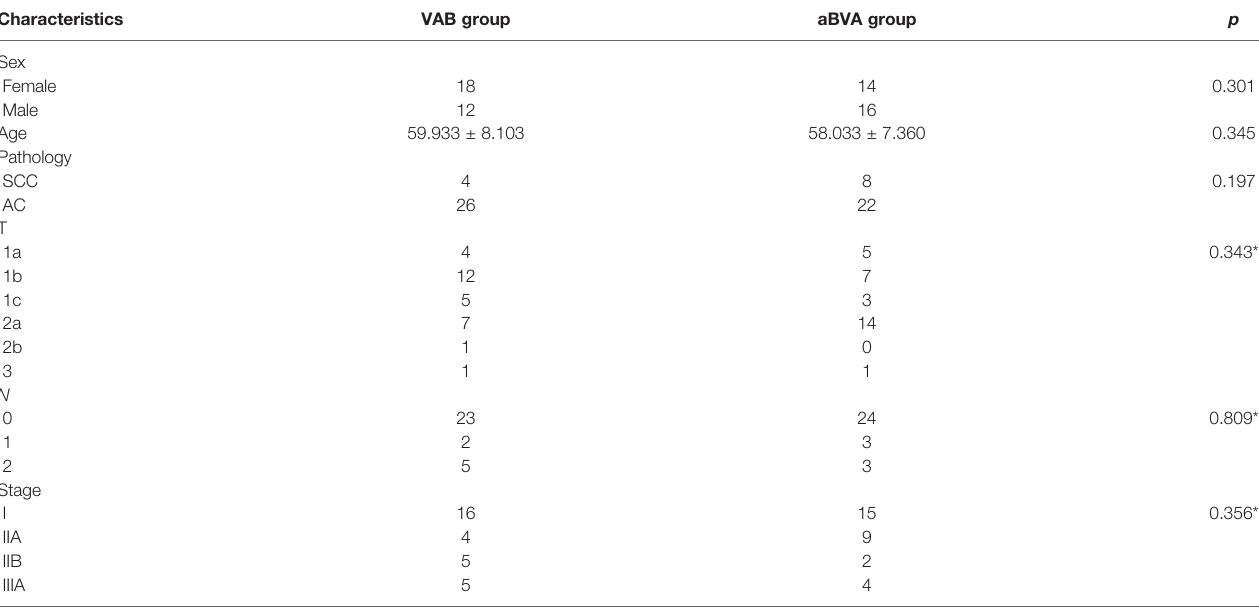
TABLE 1 | Differences in clinicopathological characteristics between the VAB and aBVA groups. Characteristics